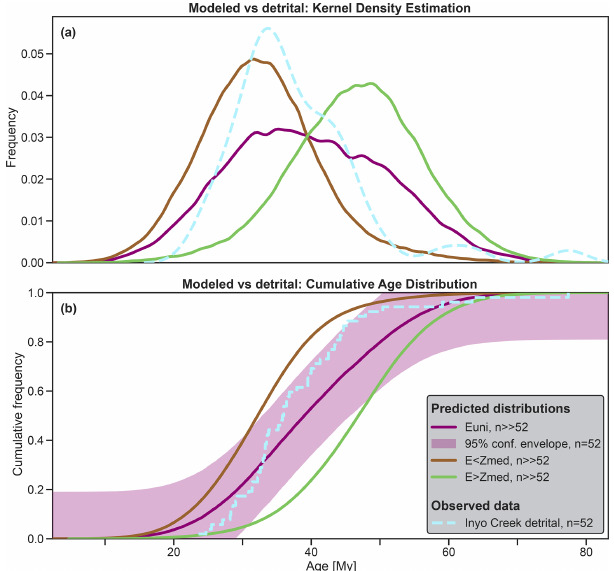
Figure 6. Kernel density estimation curves of all predicted detri- tal distributions and of the observed detrital sample (a) . Cumulative form (b) of the same distributions, plus the 95% confidence enve- lope (DKW-bounds) of “ E uni ” for n = k = 52. E uni indicates uni- form erosion, E < Z med indicates 10-fold erosion below median elevation, and E > Z med indicates 10-fold erosion above median